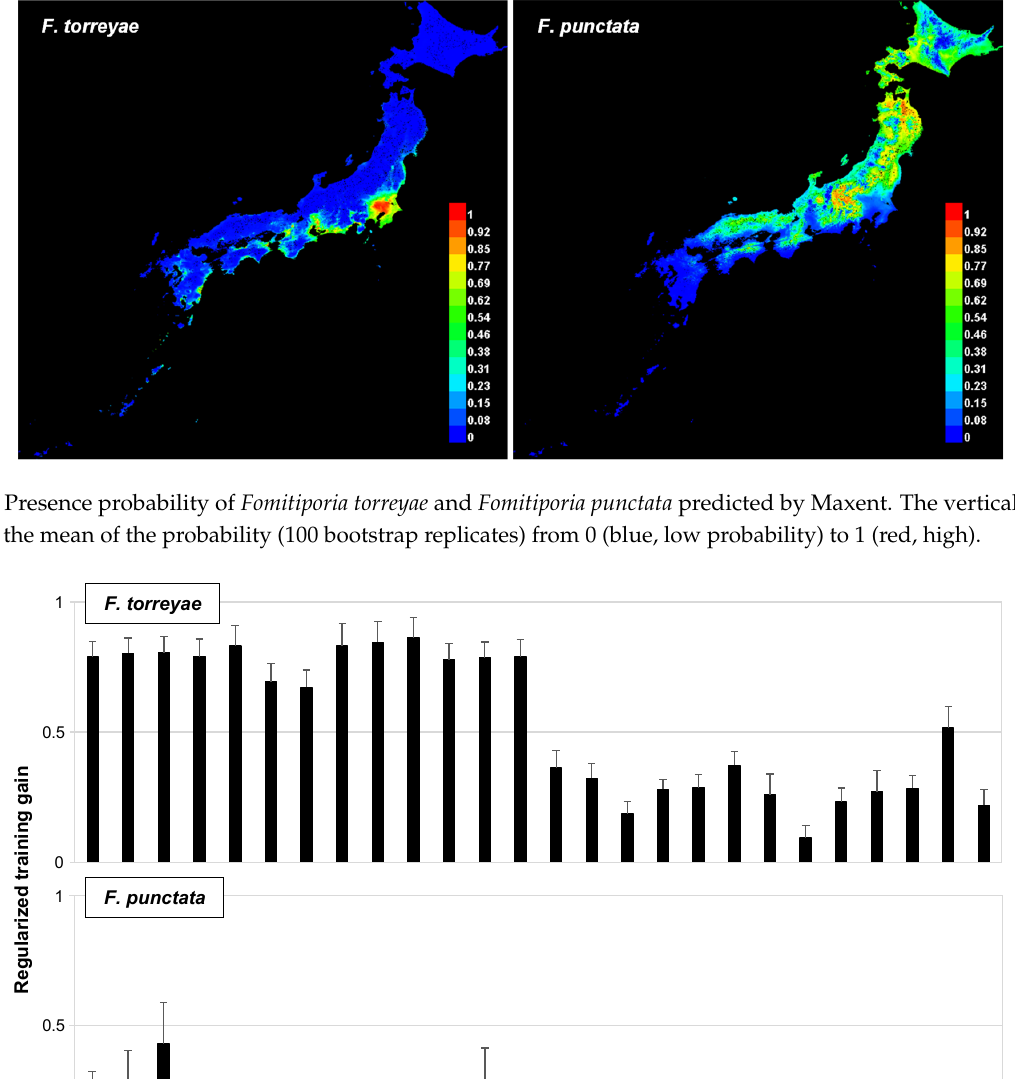
Figure 3. Relationships between presence probability and average temperature in March. Values were calculated in Maxent models using each variable alone. Red lines and blue shading show the mean of 100 bootstrap replicates and one standard deviation, respectively.